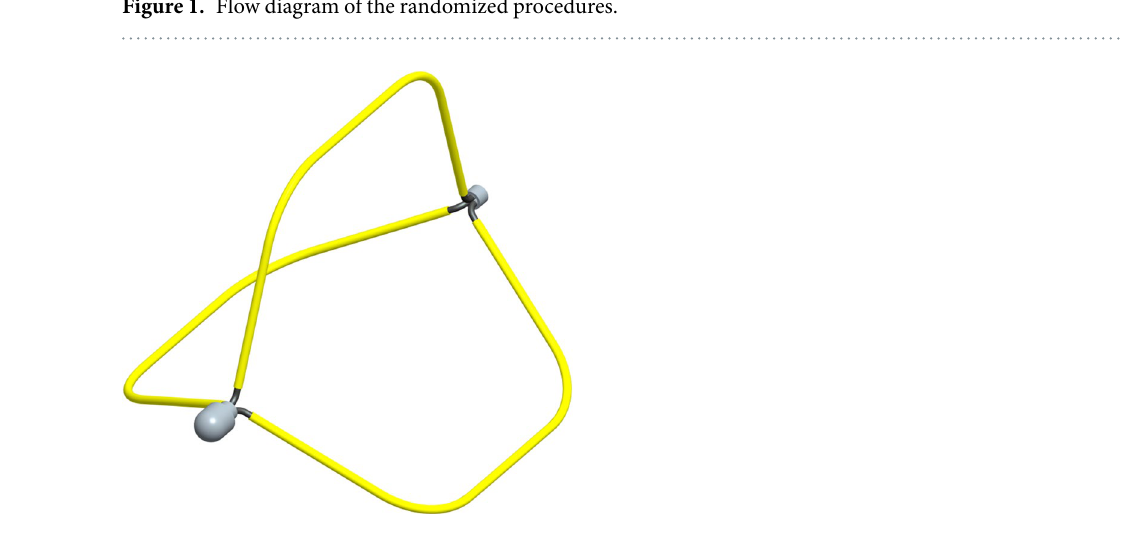
Figure 1. Flow diagram of the randomized procedures.